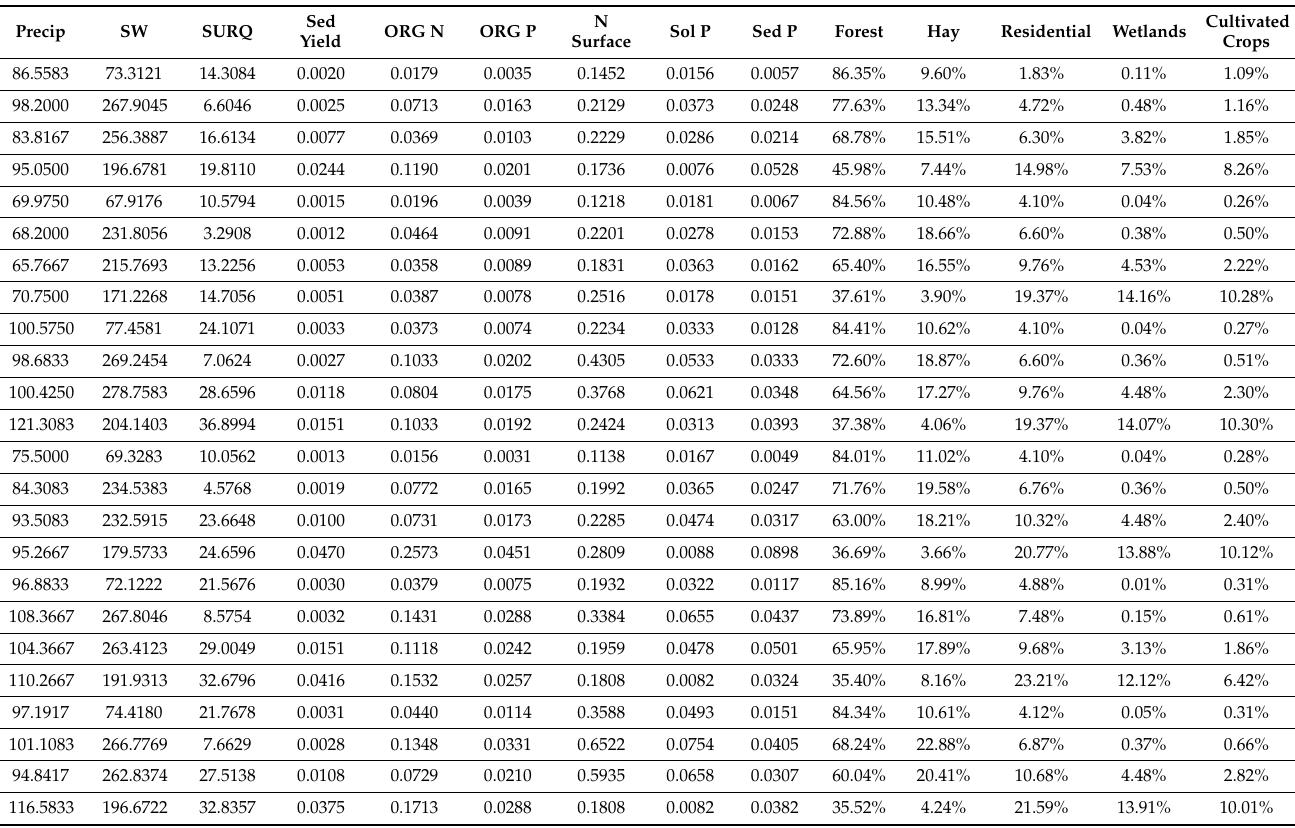
Table A3. Table showing PCA and correlation matrix setup dataset.